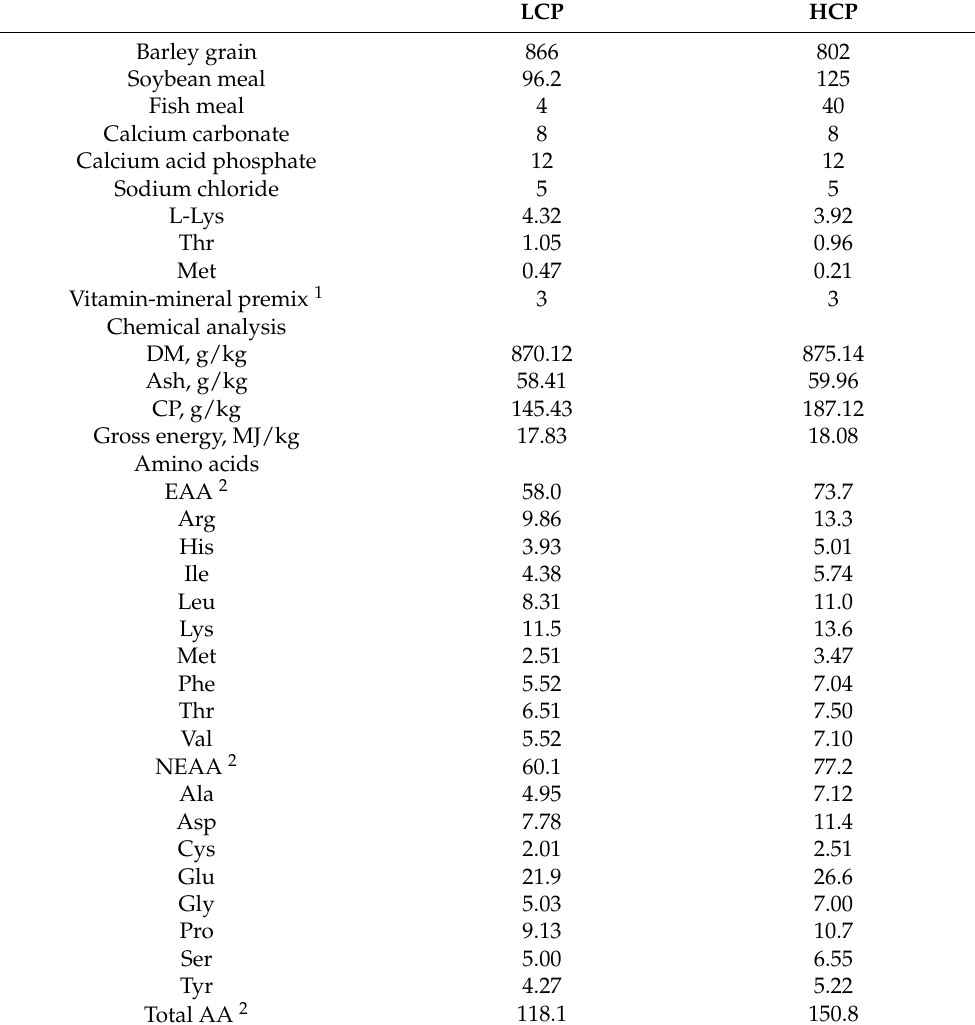
Table 1. Composition (g/kg) and chemical analysis (dry matter (DM) basis) of low (LCP) and high crude protein (HCP) content